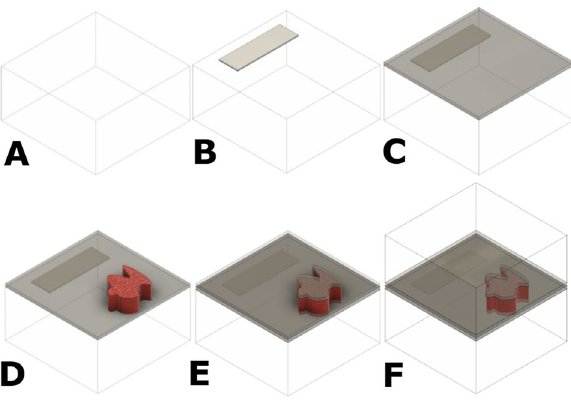
Figure 4. Preparation B scheme. (A) Cured EpoFix in 1/2 of the mould. (B) Label glued downwards. The label can also be added upwards after step (E). (C) The lower part of the resin is coated with carbon (grey). (D) The sample (red) is oriented on the resin ½ cube. (E) The surface of the sample (red) is coated with carbon (grey), which will connect with the first layer from step (C). (F) The rest of the mould is filled with the EpoFix and left for